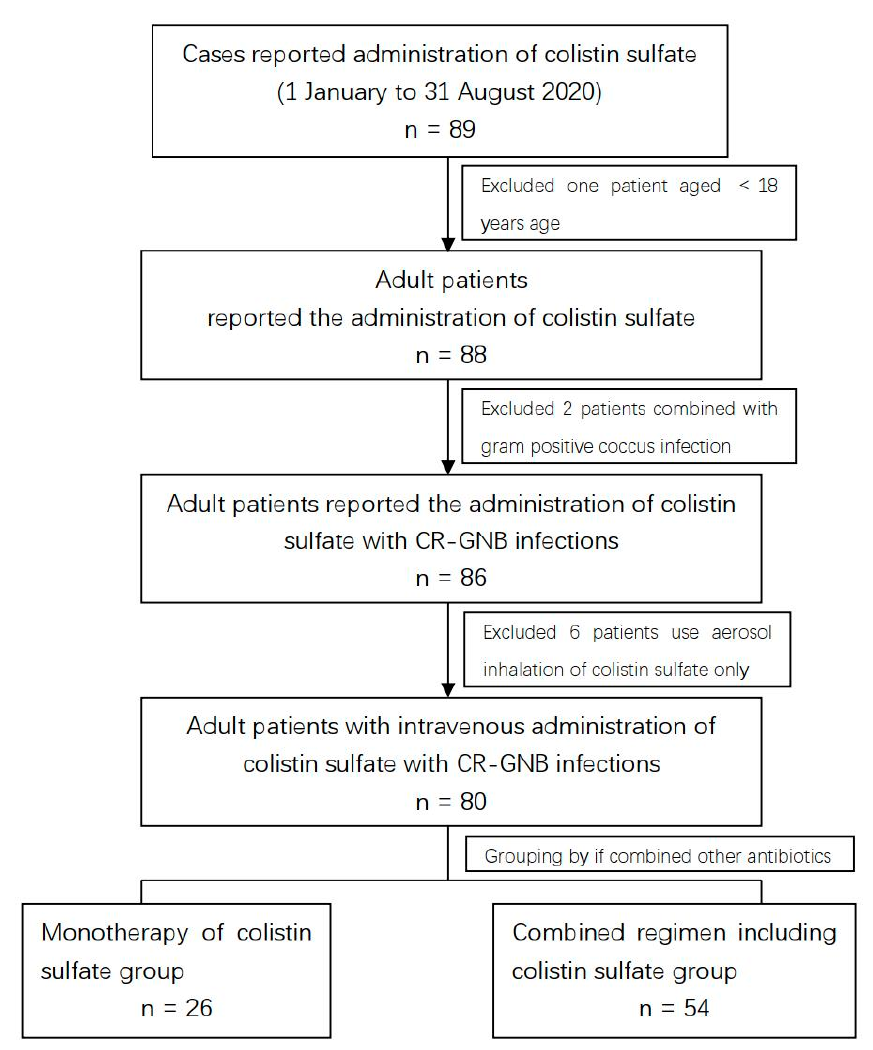
Figure 1. Case screening flowchart.